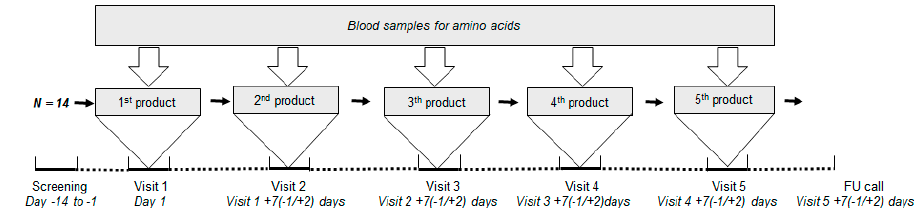
Figure 1. Schematic diagram of study design. FU = follow-up.